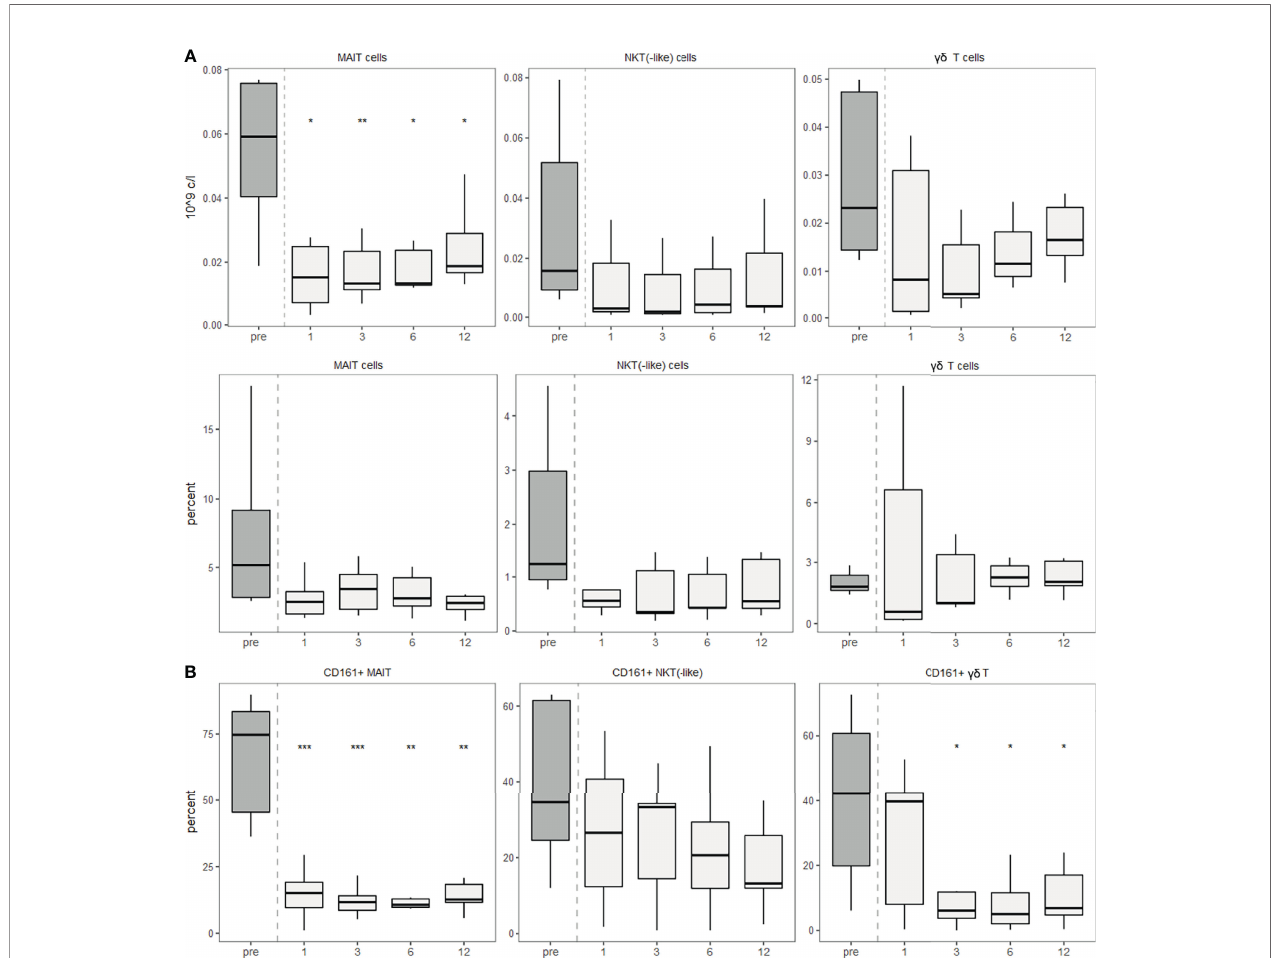
FIGURE 4 | Innate-like T cells recover slowly after aHSCT in MS and show a lower expression of CD161. PBMCs were stained with fl uorophore-conjugated surface antibodies and analyzed by fl ow cytometry. Percentages are fractions of total lymphocytes and absolute cell numbers were calculated from lymphocyte numbers measured in clinical routine. (A) Absolute (top) and relative (bottom) recovery of MAIT, NKT(-like) and gd T cells post-aHSCT in MS. (B) Percentage of CD161- expressing cells within MAIT cells (left), percentage of CD161-expressing cells within NKT(-like) cells (middle) and percentage of CD161-expressing cells within gd T cells (right). Number of samples were pre = 7, M1 = 7, M3 = 7, M6 = 7, M12 = 7. As a global test, Kruskal-Wallis was used, and in case of signi fi cance followed by pairwise comparisons (pre vs 1, 3, 6 and 12 months) using Wilcoxon signed-rank